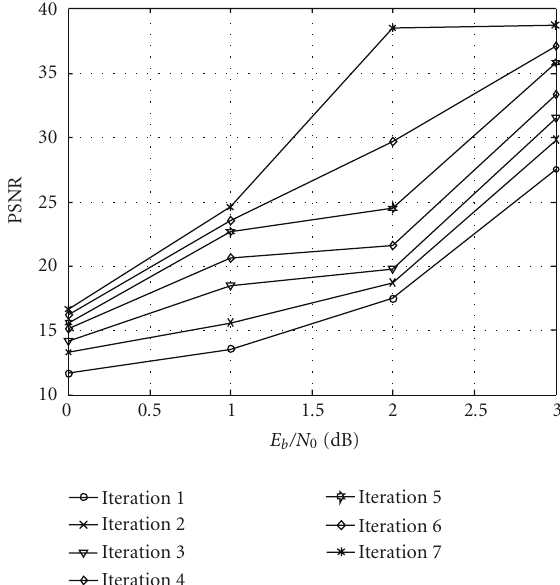
Figure 15: Decoded image quality (in PSNR) of proposed asym- metric turbo code without interleaver over AWGN channel.